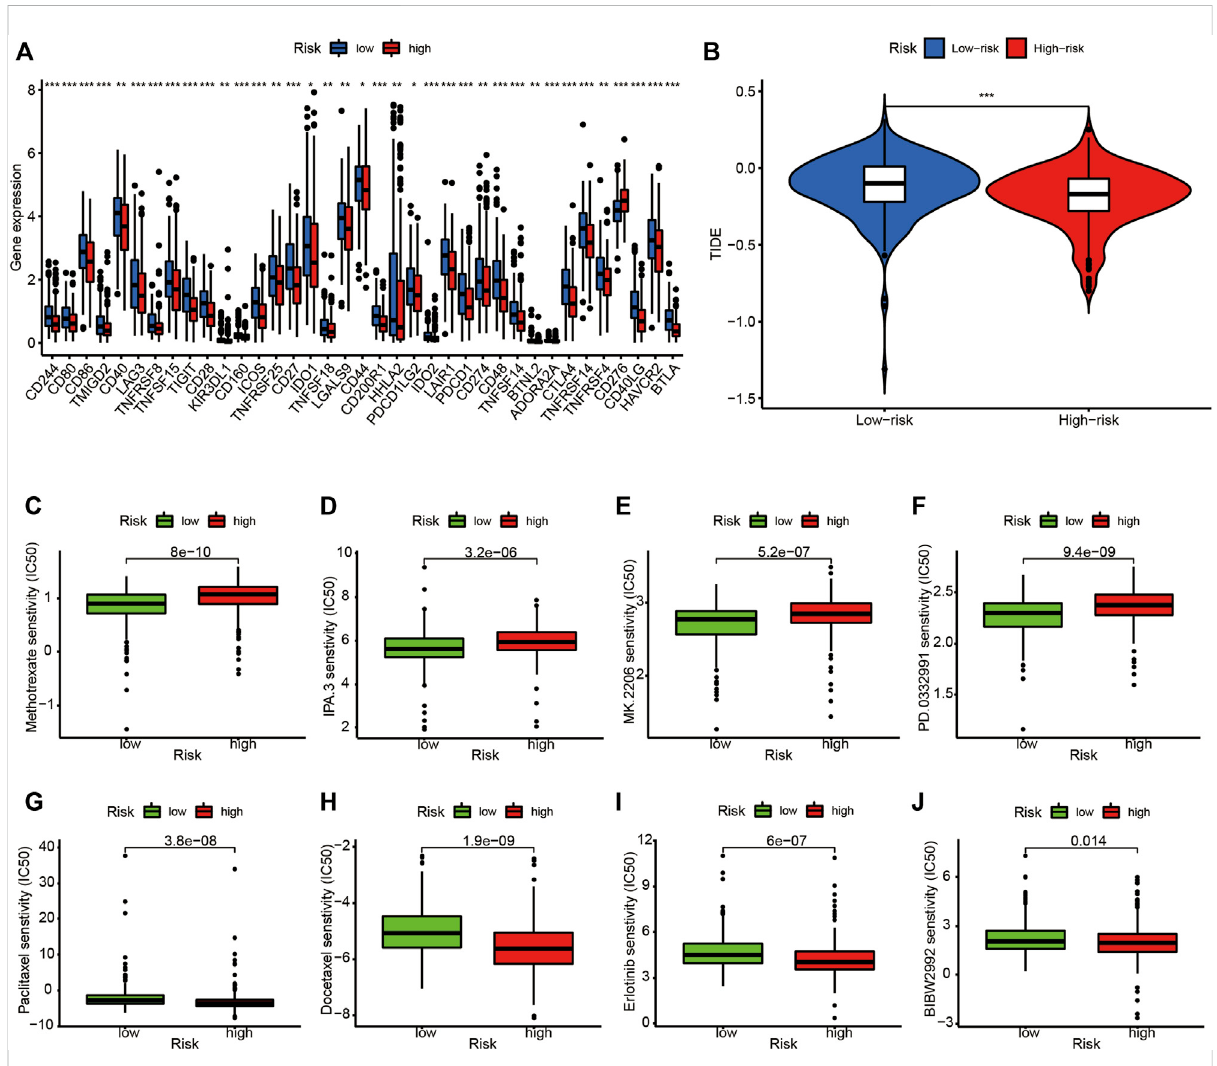
FIGURE 12 Comparison ofimmune checkpoints,TIDE scores, sensitivityof chemotherapy and targeted therapy drugsinthehigh- and low-risk groups. (A) Expression of 37 immune checkpoint genes differed between the high-risk and low-risk groups. Red boxes represent high-risk patients and blue boxes represent low-risk patients (B) . The online software TIDE prediction of the ef fi cacy score in subgroups of LUAD patients treated with anti-PD1 or anti-CTLA4. The IC 50 values for (C) methotrexate (D) IPA.3 (E) MK.2206 (F) PD.0332,991 (palbociclib) (G) paclitaxel (H) docetaxel (I) erlotinib, and (J) BIBW2992 (alphatinib) in the high-risk and low-risk groups. TIDE, tumor immune dysfunction and exclusion module; IC 50 ,